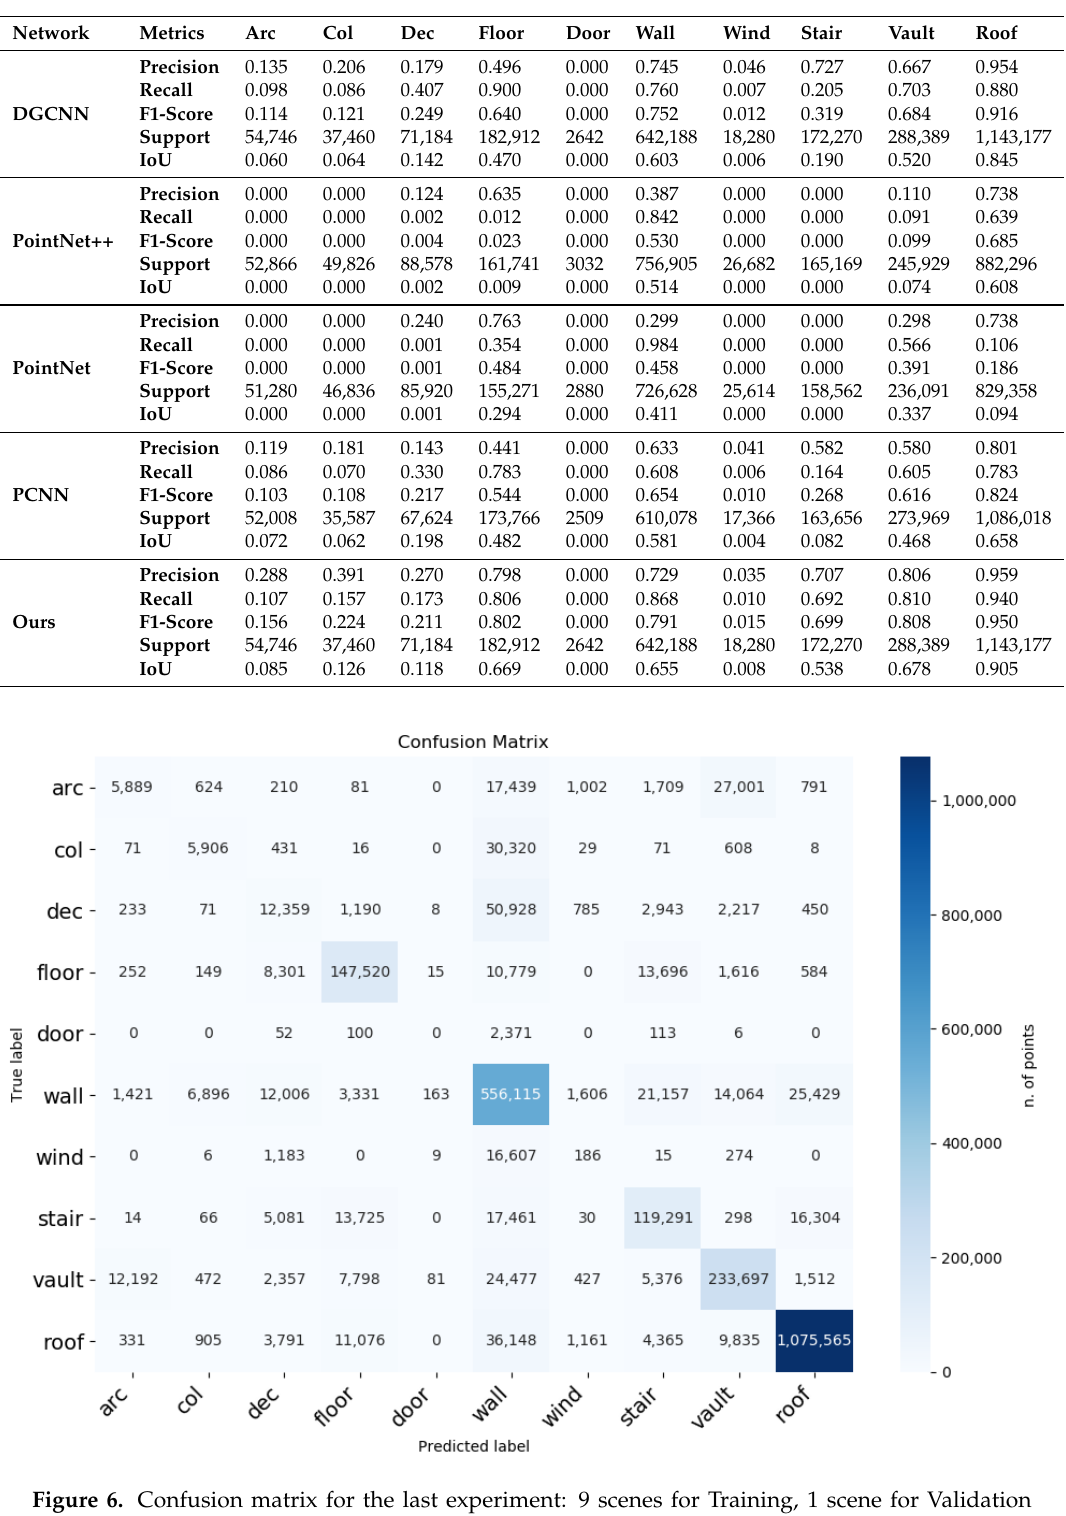
Table 6. Tests performed on all scenes of the dataset in terms of Precision, Recall, F1-Score and Support of each class for the Test scene.